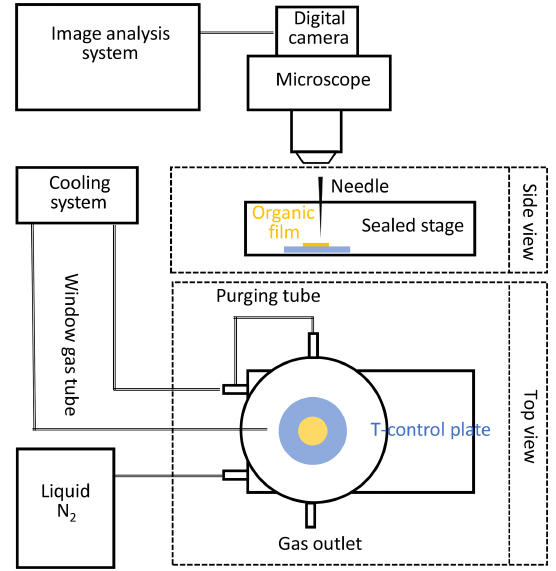
Figure 2. Schematic of the experimental poke-flow setup. This in- cludes a temperature-controlled Linkam cooling stage coupled to a microscope equipped with a digital camera and an image analysis